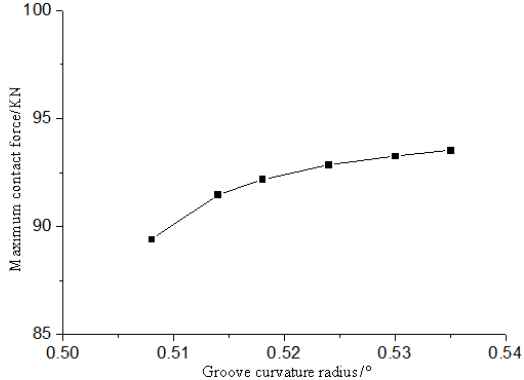
Figure 14: Effects of groove curvature coeflcient on the maximum contact